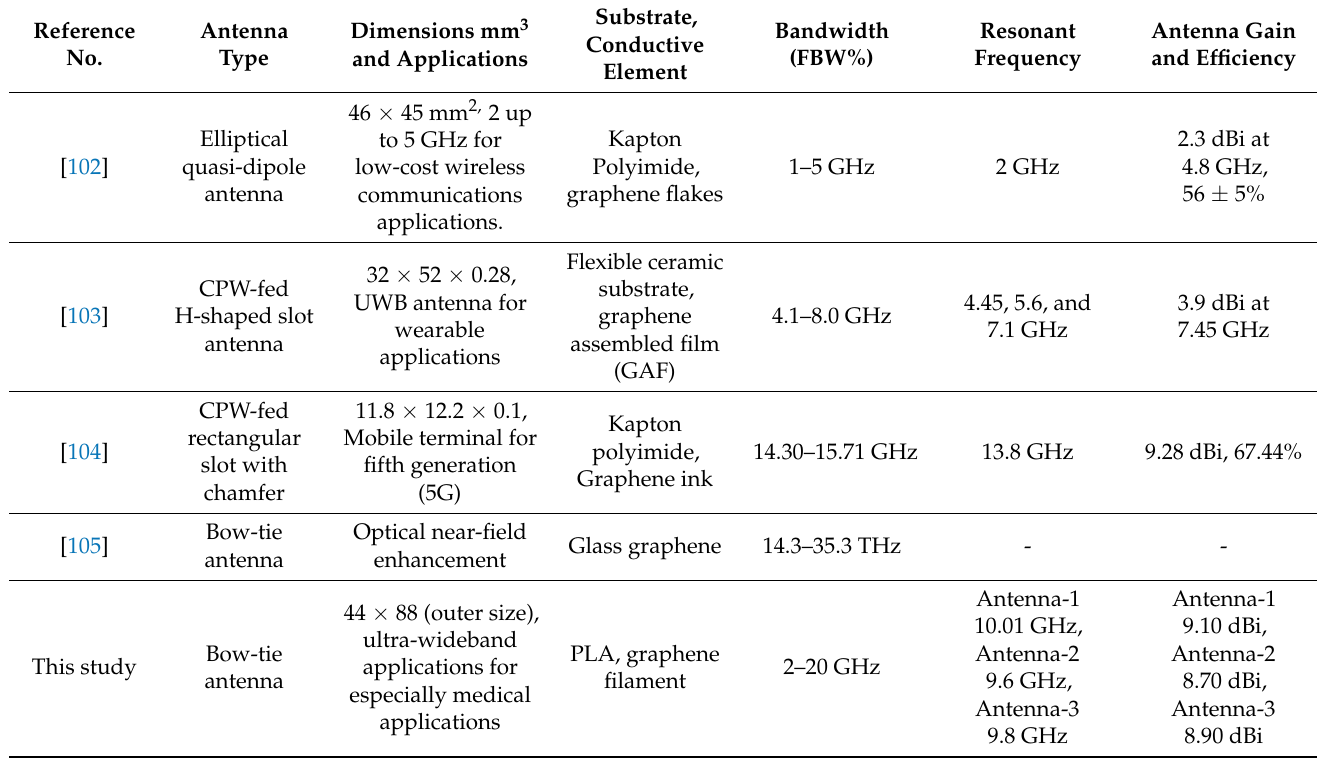
Table 5. Comparison of the manufactured antenna with some